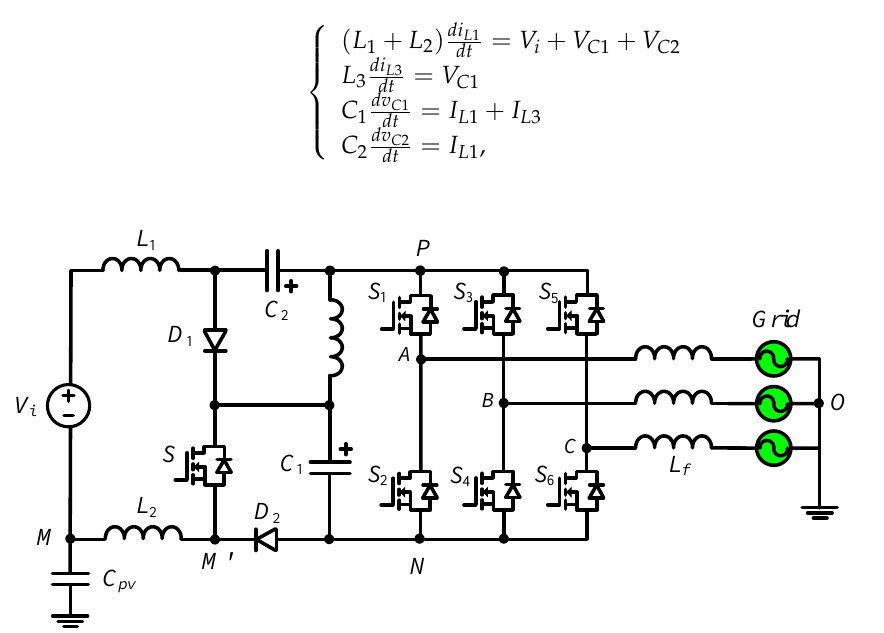
Figure 3. Three-phase modified active quasi-Z-source inverter (MAqZSI).